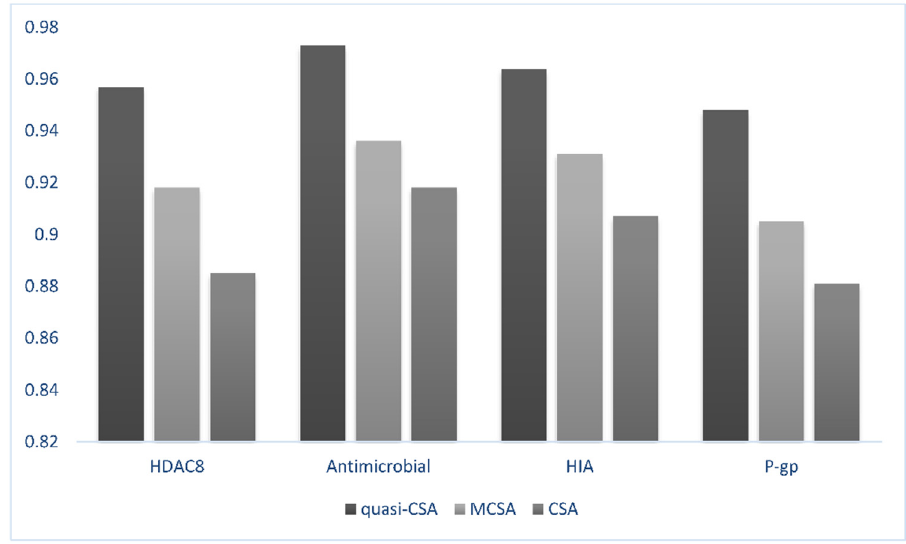
Figure 4: The results of S.test.